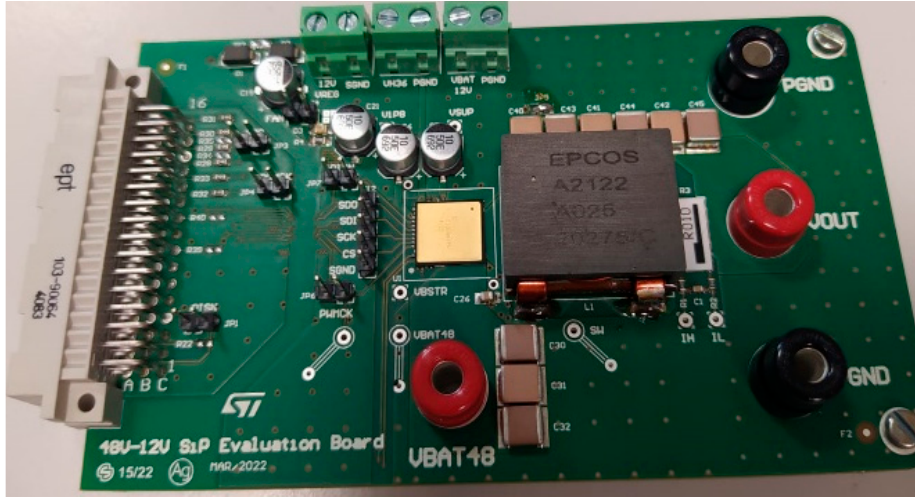
Figure 15. Evaluation board of the interleaved 48–12 V converter.